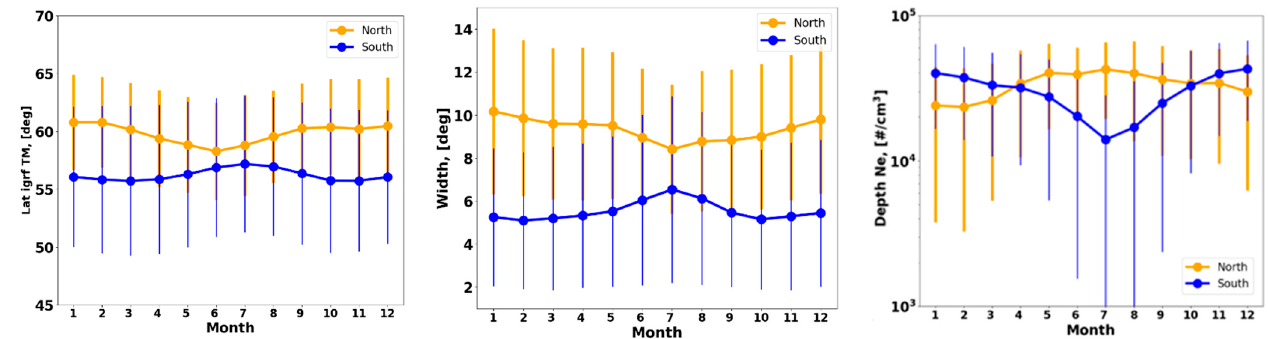
Figure 11. Monthly variation in location, depth, and width of the mid-latitude trough for the northern and southern hemispheres.